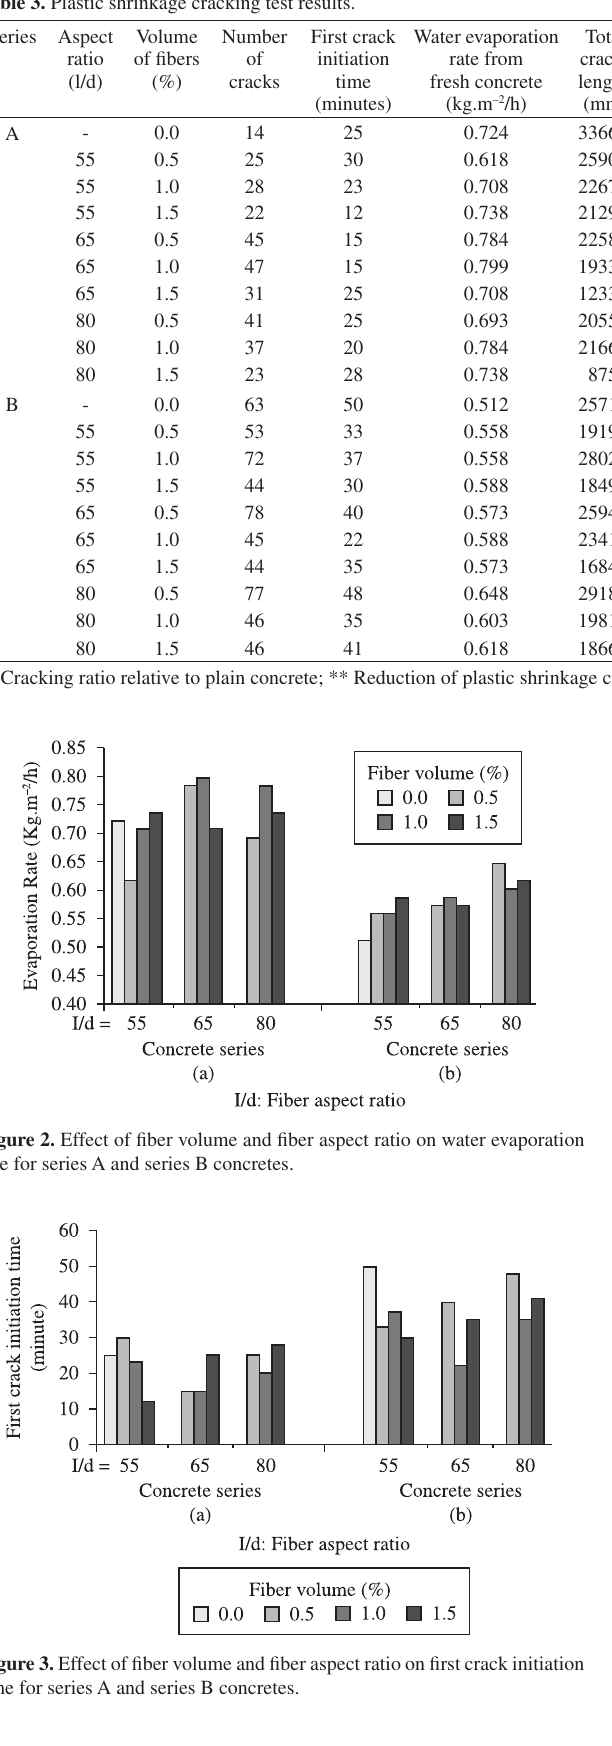
Table 3. Plastic shrinkage cracking test results.